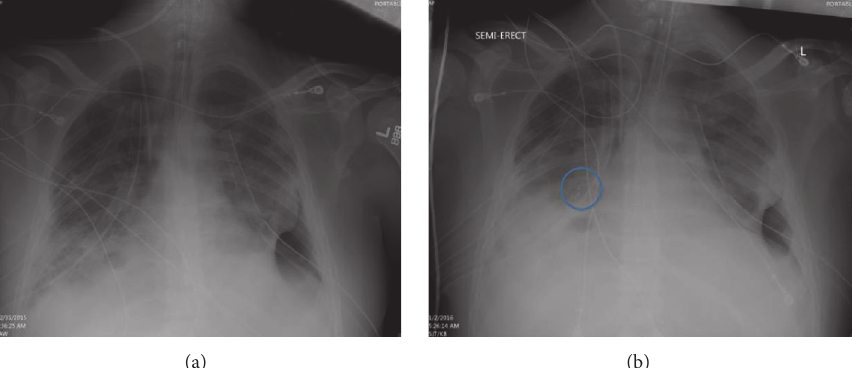
Figure 1: The left chest roenterogram represent pre-EBV placement. The right chest roenterogram represents post-EBV placement. The circled area depicts the EBV with right middle lobe atelectasis. EBV: endobronchial valve.